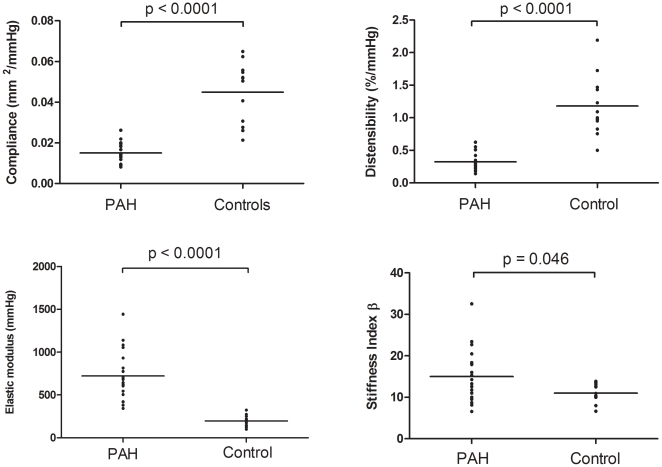
Comparison of PA stiffness indices in control (n = 12) and PAH subjects (n = 20) at baseline.PAH subjects demonstrated significantly greater stiffness in all measure indices; compliance (1.50±0.11×10–2 mm2/mmHg vs 4.49±0.43×10–2 mm2/mmHg, p<0.0001), distensibility (0.32±0.03%/mmHg vs 1.18±0.13 %/mmHg, p<0.0001), elastic modulus (720±64 mmHg vs 198±19 mmHg, p<0.001), and stiffness index β (15.0±1.4 vs 11.0±0.7, p = 0.046). Data expressed as mean±SEM.